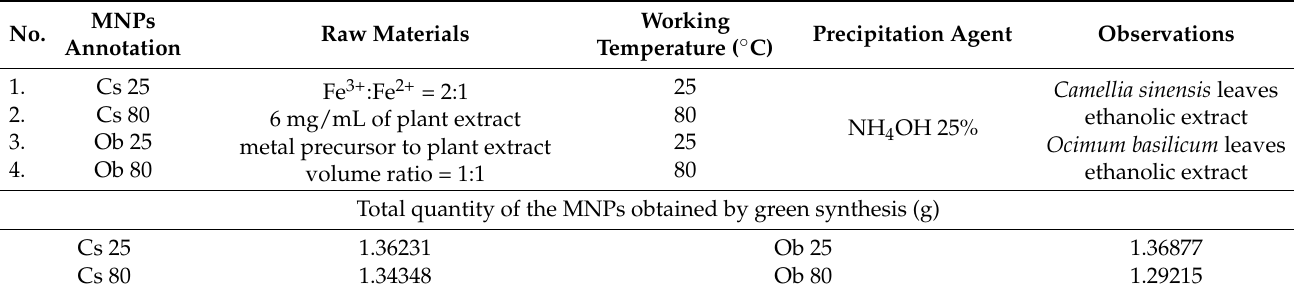
Table 1. The synthesis conditions used for MNPs’